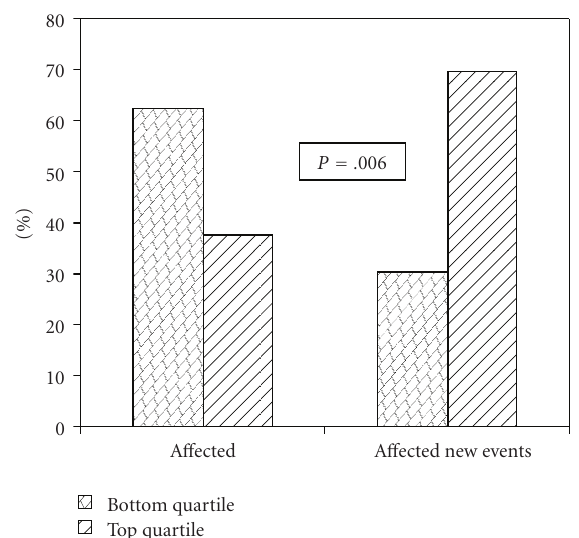
Figure 2: Distribution of subjects according to high-sensitivity C- reactive protein (hsCRP)